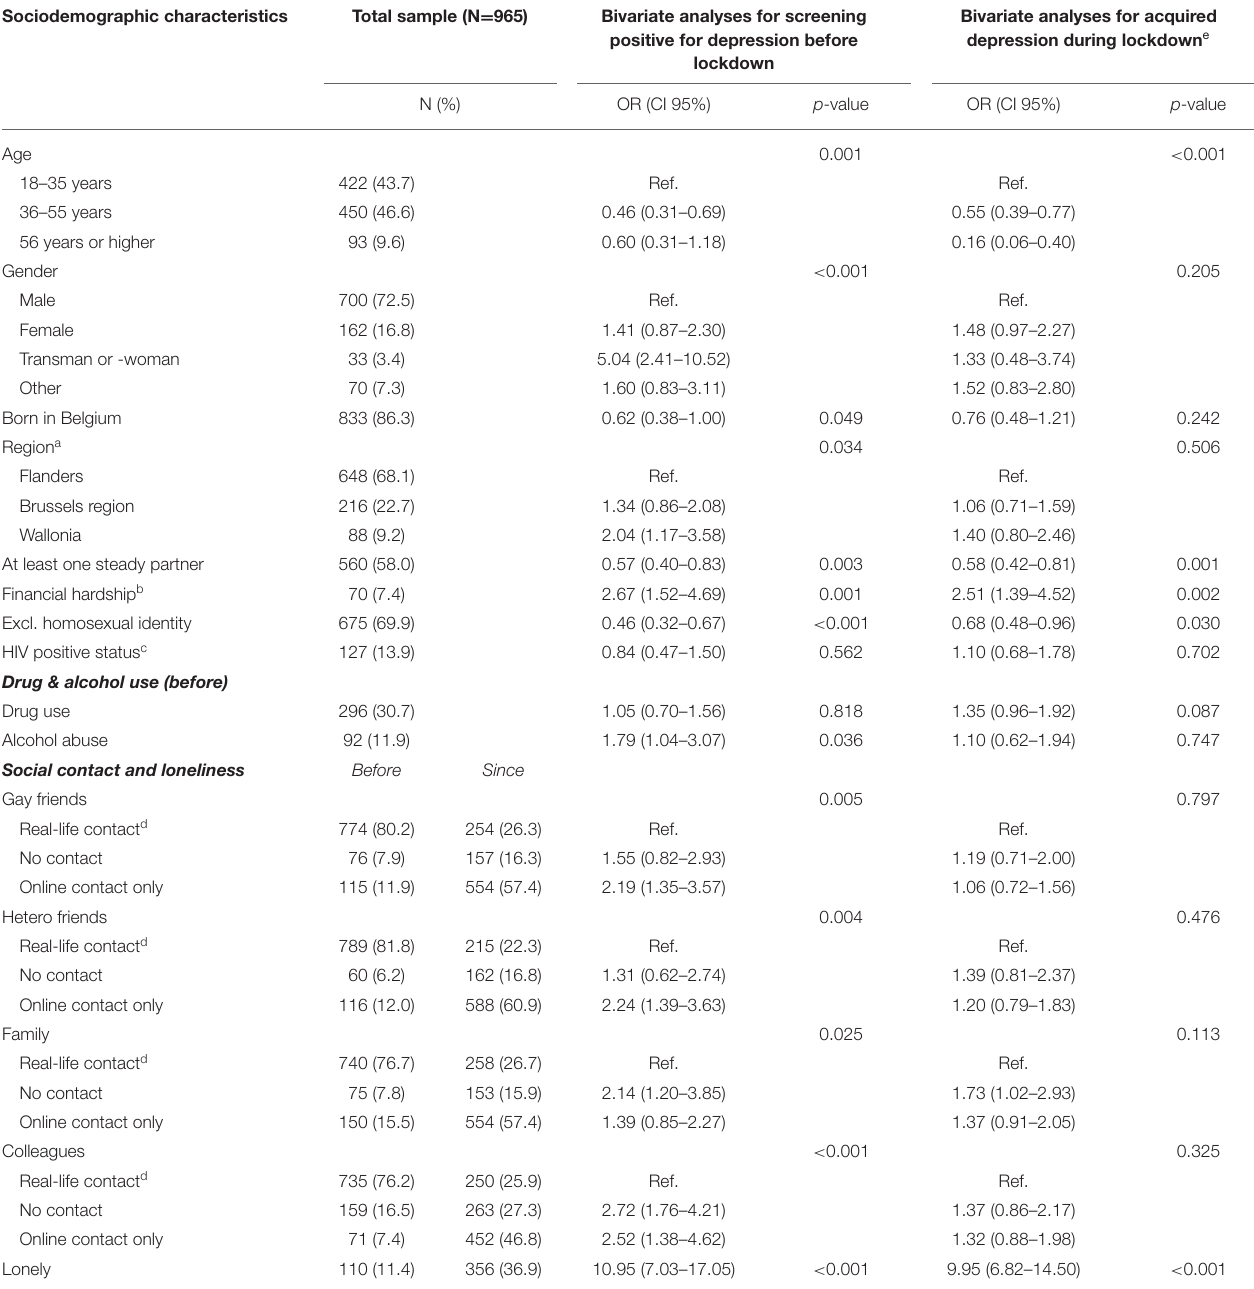
TABLE 1 | Bivariate analyses for associations between sociodemographic factors, alcohol and drug use and social contact, and having or gaining a positive screening status for depression before and during the lockdown. Sociodemographic characteristics Total sample (N = 965) Bivariate analyses for screening